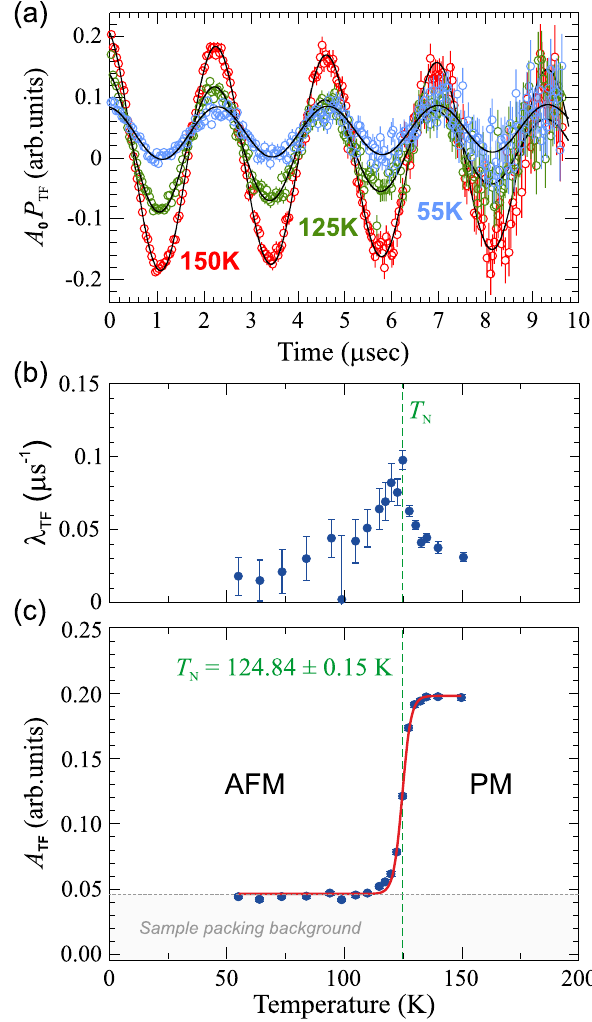
Figure 1. ( a ) Weak transverse field (wTF) µ + SR spectra in the long time domain above the transition temperature for LiCrTe 2 . The spectra are overlapped to show the oscillation around 0 asymmetry. ( b ) Temperature dependence of the depolarisation rate of the wTF signal. ( c ) Temperature dependence of the wTF asymmetry, the solid line is a fit to a sigmoid curve. The transition temperature resulting from the fit is given in the